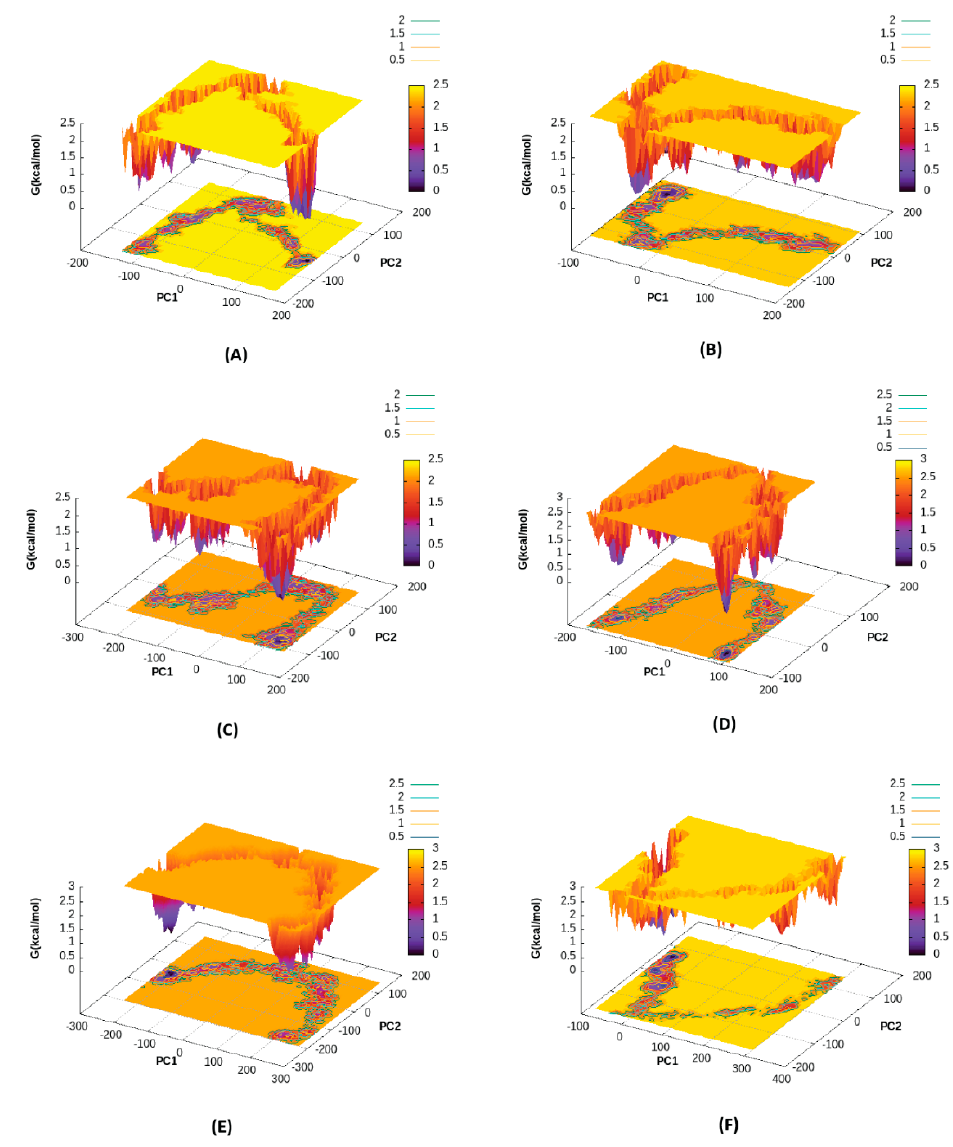
Figure 5. Free Energy Landscape of GPR109A/B—HA Complex, ( A ) GPR109A − HA, pose − A0 ( B ) GPR109A − HA, pose − A1 ( C ) GPR109B − HA, pose − B0 ( D ) GPR109B − HA, pose − B1 ( E ) Chimera 3A4B − HA ( F ) Chimera 3B − HA.